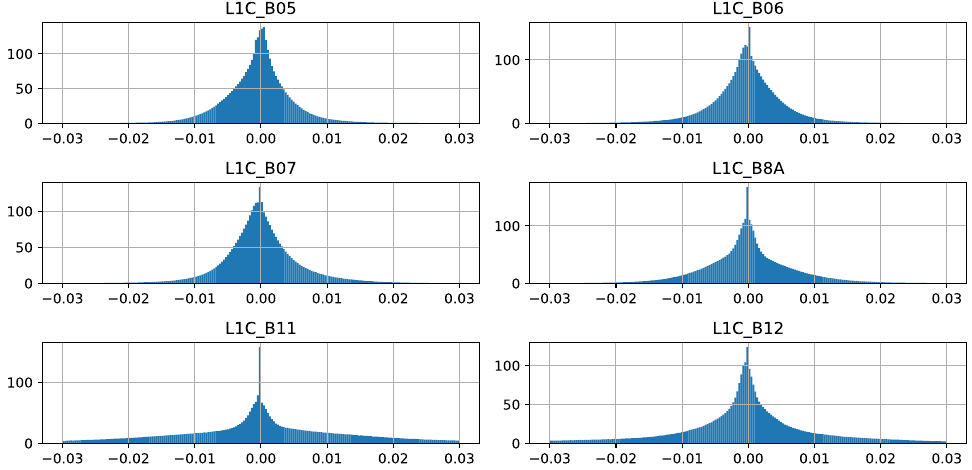
Figure 9. Histograms of the errors (true value minus prediction) for the L1C bands. (cid:0)(cid:1)(cid:2)(cid:3)(cid:1)(cid:4)(cid:4)(cid:5)(cid:6)(cid:2)(cid:7)(cid:8)(cid:2)(cid:6)(cid:9)(cid:10)